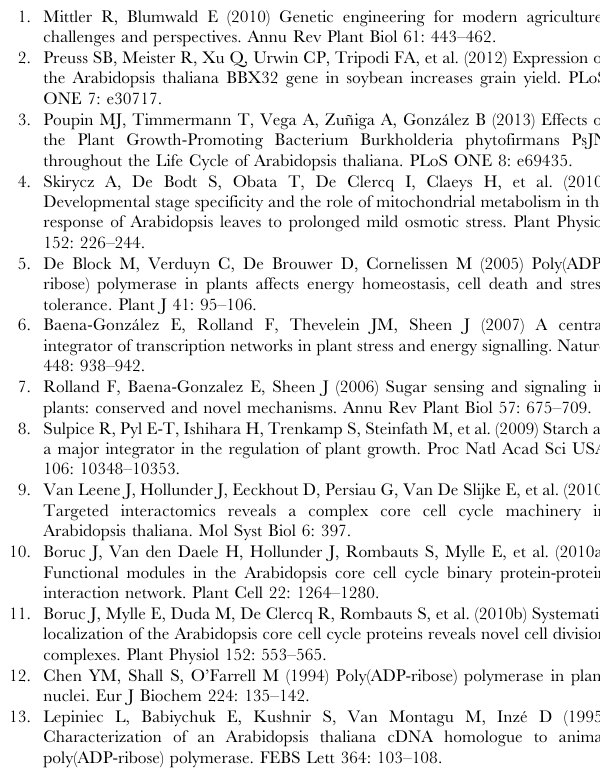
Table S2 Complete list of detected primary metabo- lites. For the GC-MS analysis samples were taken in parallel to samples for the physiological measurements for both conditions ( + / 2 3MB) at day1, day2, day4 and day7. The experiment was repeated three times independently with five replicates each (n= 15). Relative abundance of metabolite in the 3MB treated sample compared to the control samples are shown. (PDF) Table S3 Complete list of detected secondary metabo- lites. For LC-MS metabolite profiling 5 replicate samples were taken in parallel to samples to the GC-MS for both conditions ( + / 2 3MB) seven days after transfer (day 14) in three independent experiments (n =15). Metabolites with significant changes in their relative abundance in the PARP inhibited plants are shown in bold. Individual peak number, the chemical sum formula of the detected compound and the KEGG as well as Knapsack annotation were shown.